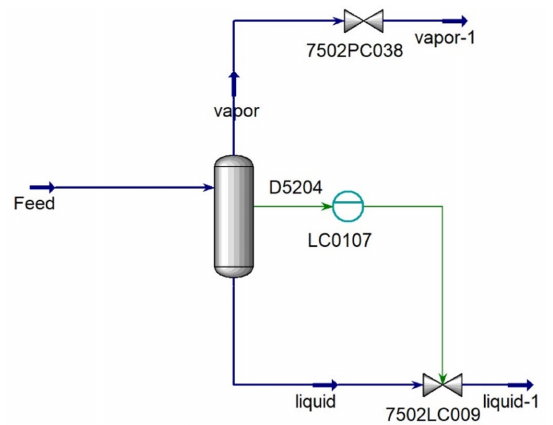
Figure 4. Graphical representation of